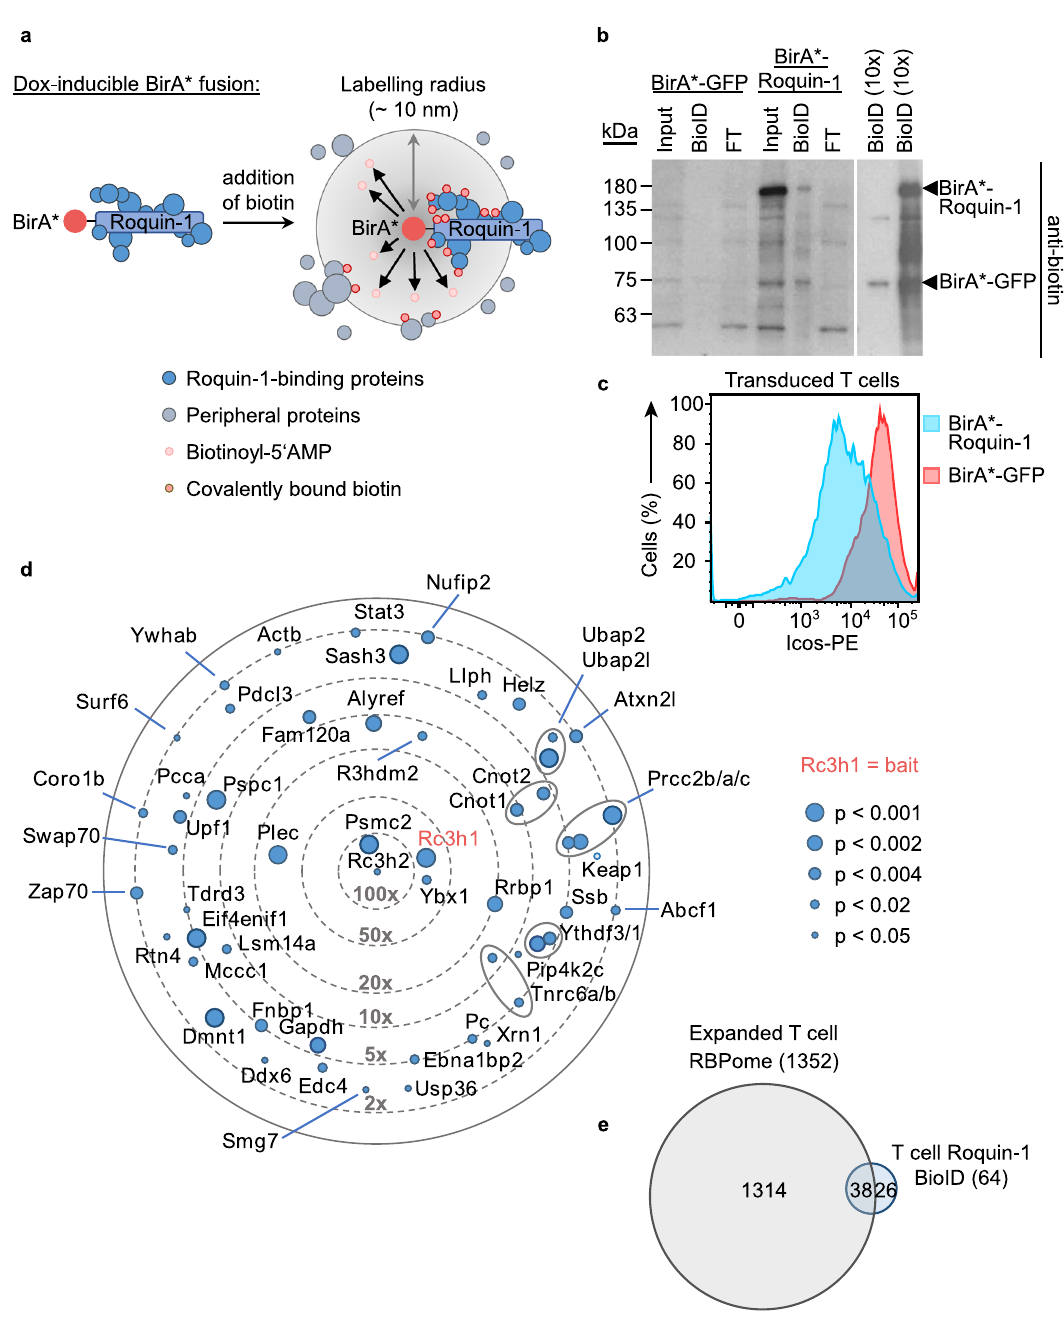
Fig. 6 Identi fi cation of proteins in proximity to Roquin-1 in CD4 + T cells. Expression of BirA*-Roquin-1 and biotin tagging de fi ne a subset of the T cell RBPome in close proximity to Roquin-1. a Schematic overview of the BioID method showing how the addition of biotin to the medium leads to the activation of biotin, diffusion of biotinoyl-5 ’ AMP and the biotinylation of the bait (Roquin-1) and all preys in the circumference. b Equimolar amounts of protein were loaded onto a PAGE gel for Western blotting applying an anti-biotin antibody. Ef fi cient biotinylation of both baits BirA*-Roquin-1 and BirA*-GFP (control) could be demonstrated ( n = 2). c Histogram showing that transduction of CD4 + T cells with retrovirus to inducibly express BirA*-Roquin-1 lead to the ef fi cient downregulation of endogenous Icos. d Identi fi ed preys from Roquin-1 BioIDs ( n = 5) in CD4 + T cells. Depicted are all signi fi cantly enriched proteins with the exception of highly abundant ribosomal and histone proteins. A two-sided heteroscedastic Student ’ s T -test analysis was performed. Dot sizes equal p -values and positioning towards the center implies increased x -fold enrichment over BirA*-GFP BioID results. e Venn diagram showing the overlap of RBPs from the CD4 + T cell RBPome with the proteins identi fi ed by Roquin-1 BioID in T cells. Source data are provided as a Source Data fi (supplemented with 10% (vol/vol) FCS, penicillin – streptomycin (100U/ml, Gibco) produced antibodies were obtained in collaboration with and from Regina Feederle and Hepes, pH 7.2 (10mM, Gibco)). (Helmholtz Center Munich). After differentiation for 36 – 48h cells were expanded for 2 – 3 days. iTreg cells were cultured in RPMI and 2000 units Proleukin S (02238131, MP Biomedicals) and T eff cells with 200 units Proleukin S. We only used iTreg cells for experiments if samples achieved at least 80% Foxp3 positive cells Culture preparation of human CD4 + T cell blasts . The use of the material of (00552300, Foxp3 Staining Kit, BD Bioscience). EL-4 T cells were cultured in the human origin in this work was approved by the ethics committee of the Technical same medium as primary T cells. HEK293T cells were cultured in DMEM University of Munich (approvals 934/03 and 1872/07) and was in accordance with